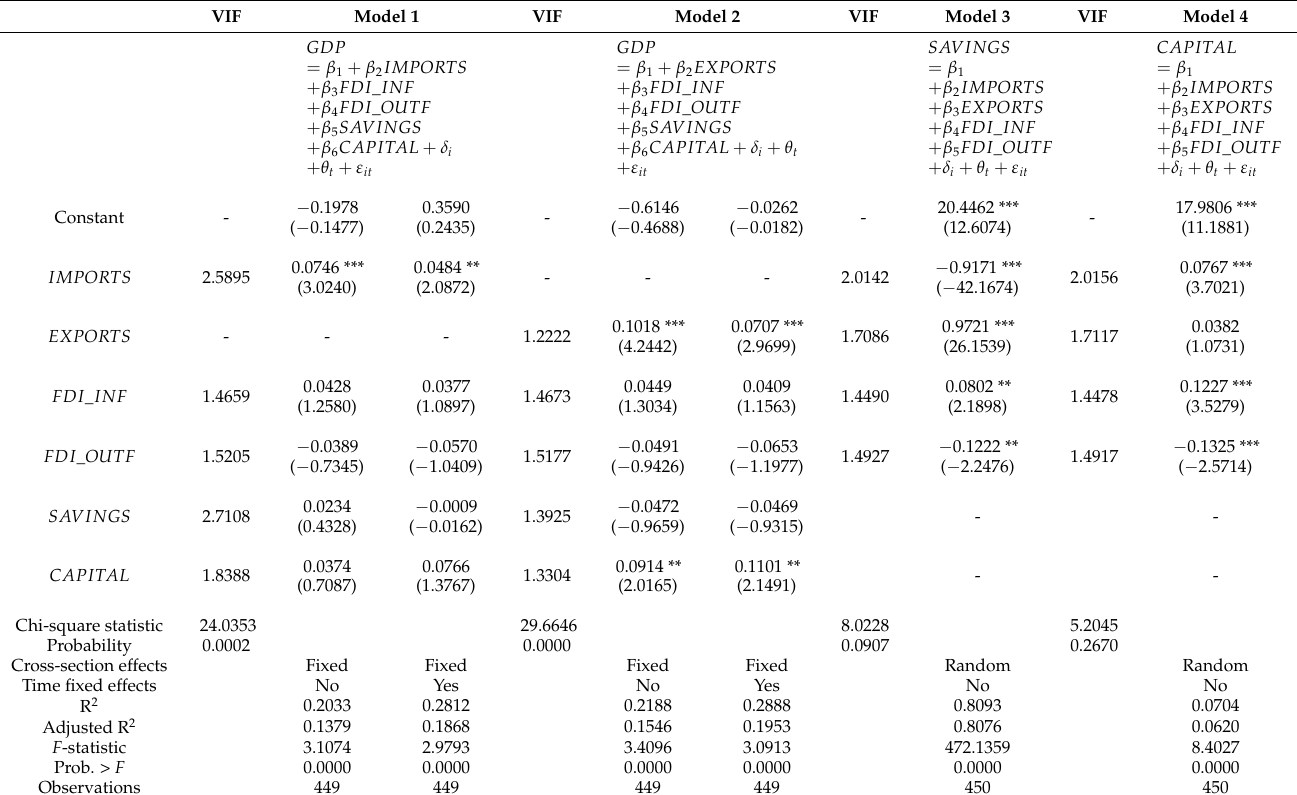
Table 3. Econometric models with cross-section fixed and random